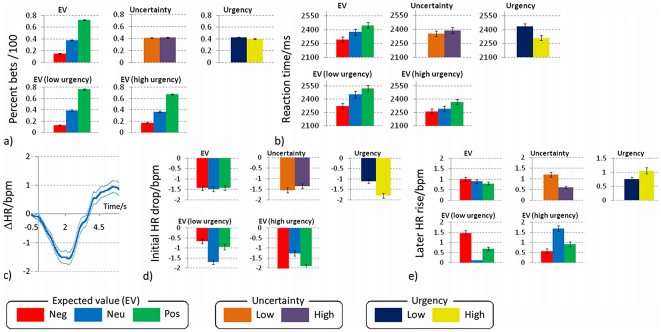
Behavioural and physiological results.Main effects and interactions of EV, uncertainty and urgency on percent bets (a) and reaction time (b). c) Average heart rate change (bpm) over single trials, dashed lines represent standard error of the mean. Main effects and interactions of EV, uncertainty and urgency on heart rate (HR) deceleration(d) and later rise (e).